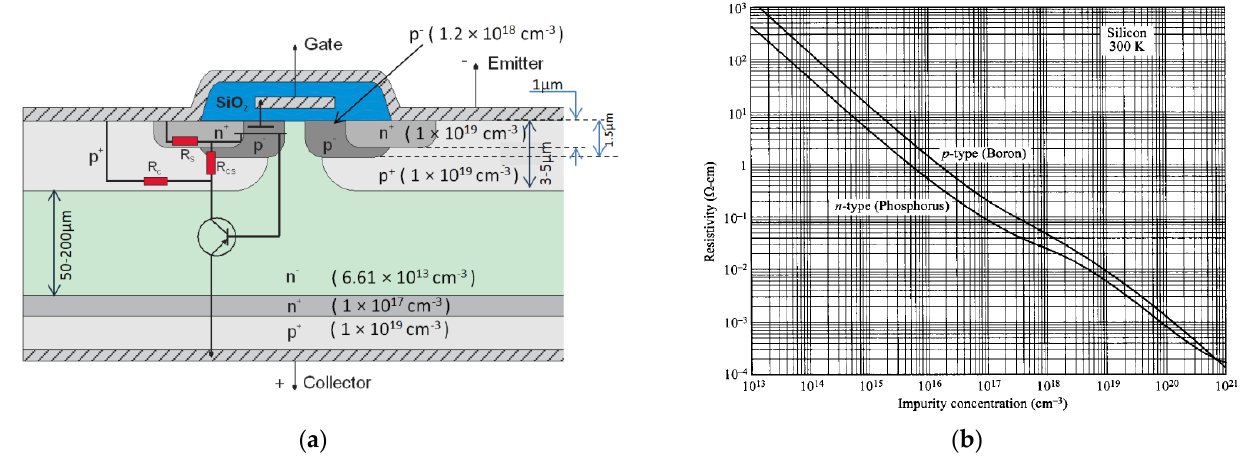
Figure 3. Diagram of IGBT cell ( a ) and resistivity vs. impurity concentration at 300 K for silicon ( b ) from [20].